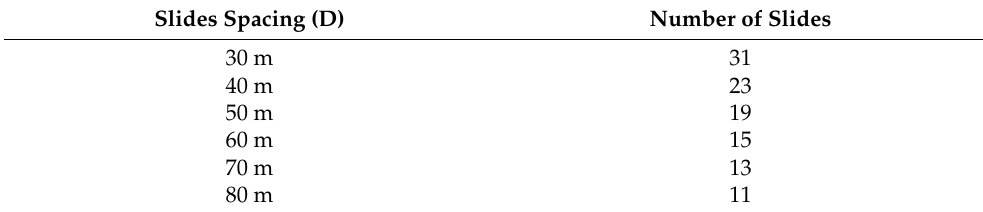
Table 2. Schemes of tunnel slide spacing.